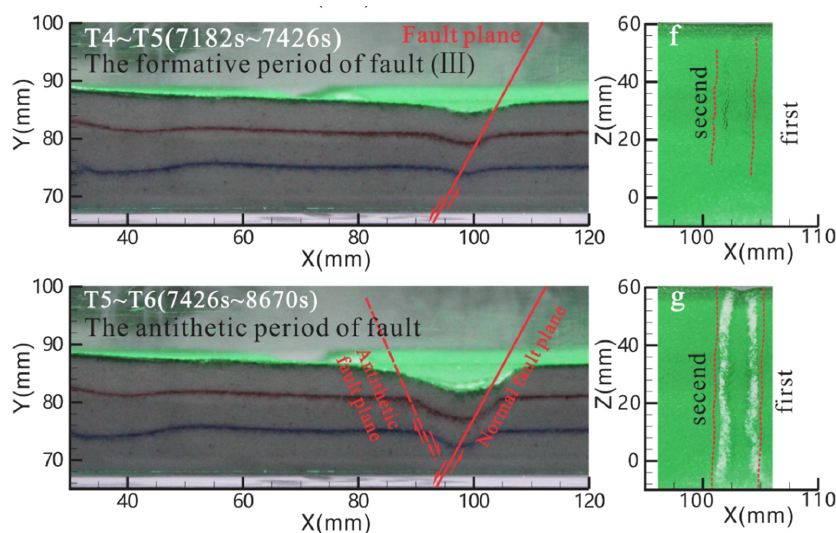
Figure 6. Experimental phenomenon of a physical simulation experiment. We depict the experimental phenomenon in detail and the calculated PIV, as shown in Figure 7. The triangular facet, which is the outcrop characteristic of the normal fault [45] can be observed in the simulation chamber. Generally, a fault line is a line that is commonly plotted on geologic maps to represent a fault and a fault plane where the fault can be seen or mapped on the surface. However, the fault plane is a plane that represents the fracture surface of a fault. In this study, we define the fault line as the localized shear zone, and the fault zone as the more distributed deformation around the localized shear zone. It is well known that the fault line is the central region of the normal fault that best reflects its formation and evolution. Four equally spaced recording points on the fault line are selected to analyze the dip angle and fault displacement change over time in this study.